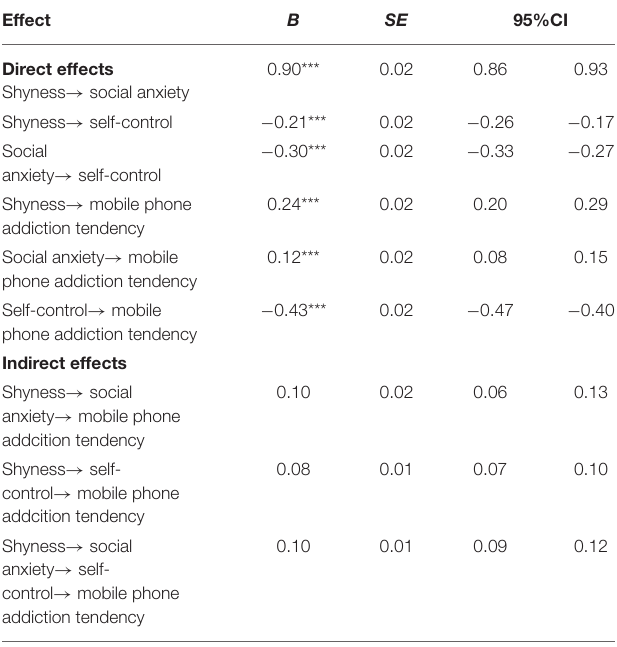
TABLE 5 | Testing the pathways of the multiple mediation